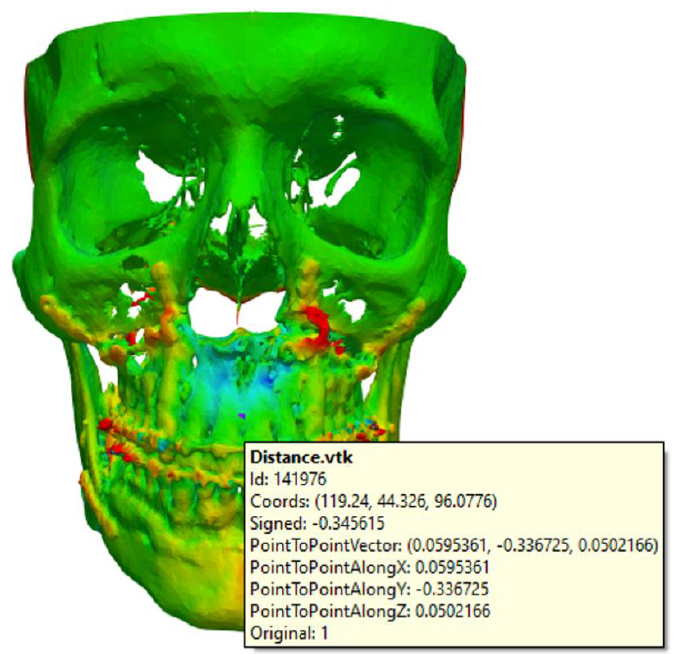
Figure 4. Values (mm) of the different components of the distance for an example point (in purple) are displayed on the postoperative model.